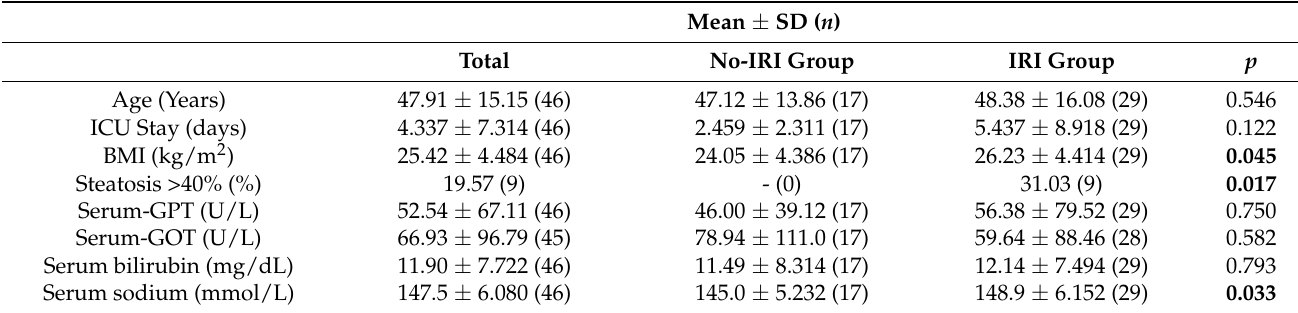
Table 3. Continuous variables of the marginality criteria according to Eurotransplant related to the donor and the transplant. SD, standard deviation; GPT, glutamic-pyruvic